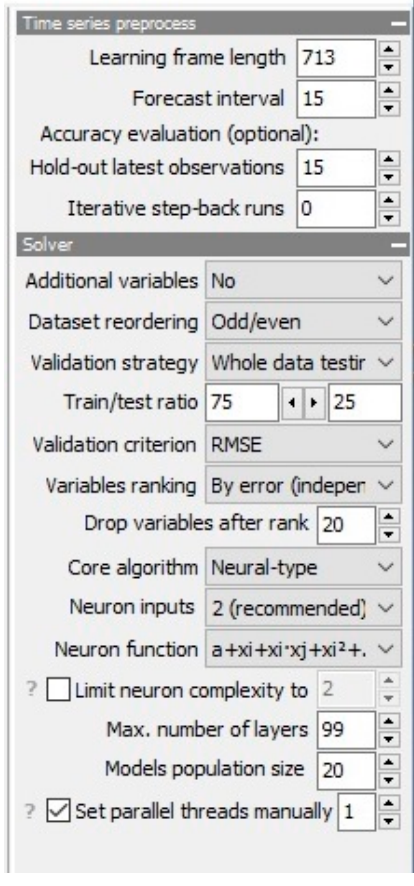
Figure 1. GMDH Shell solver application view.